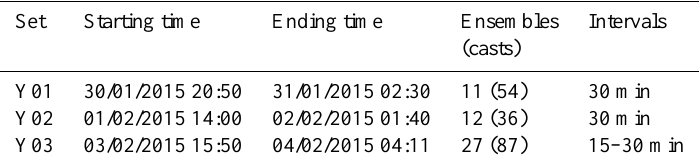
Table 1. Specifics of each yoyo set. Times are in UTC. Set Starting time Ending time Ensembles